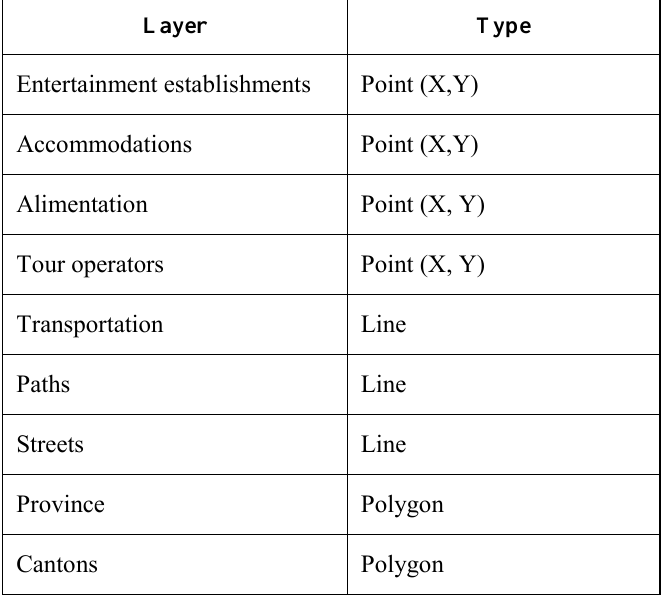
Table 3: Types of layers in the